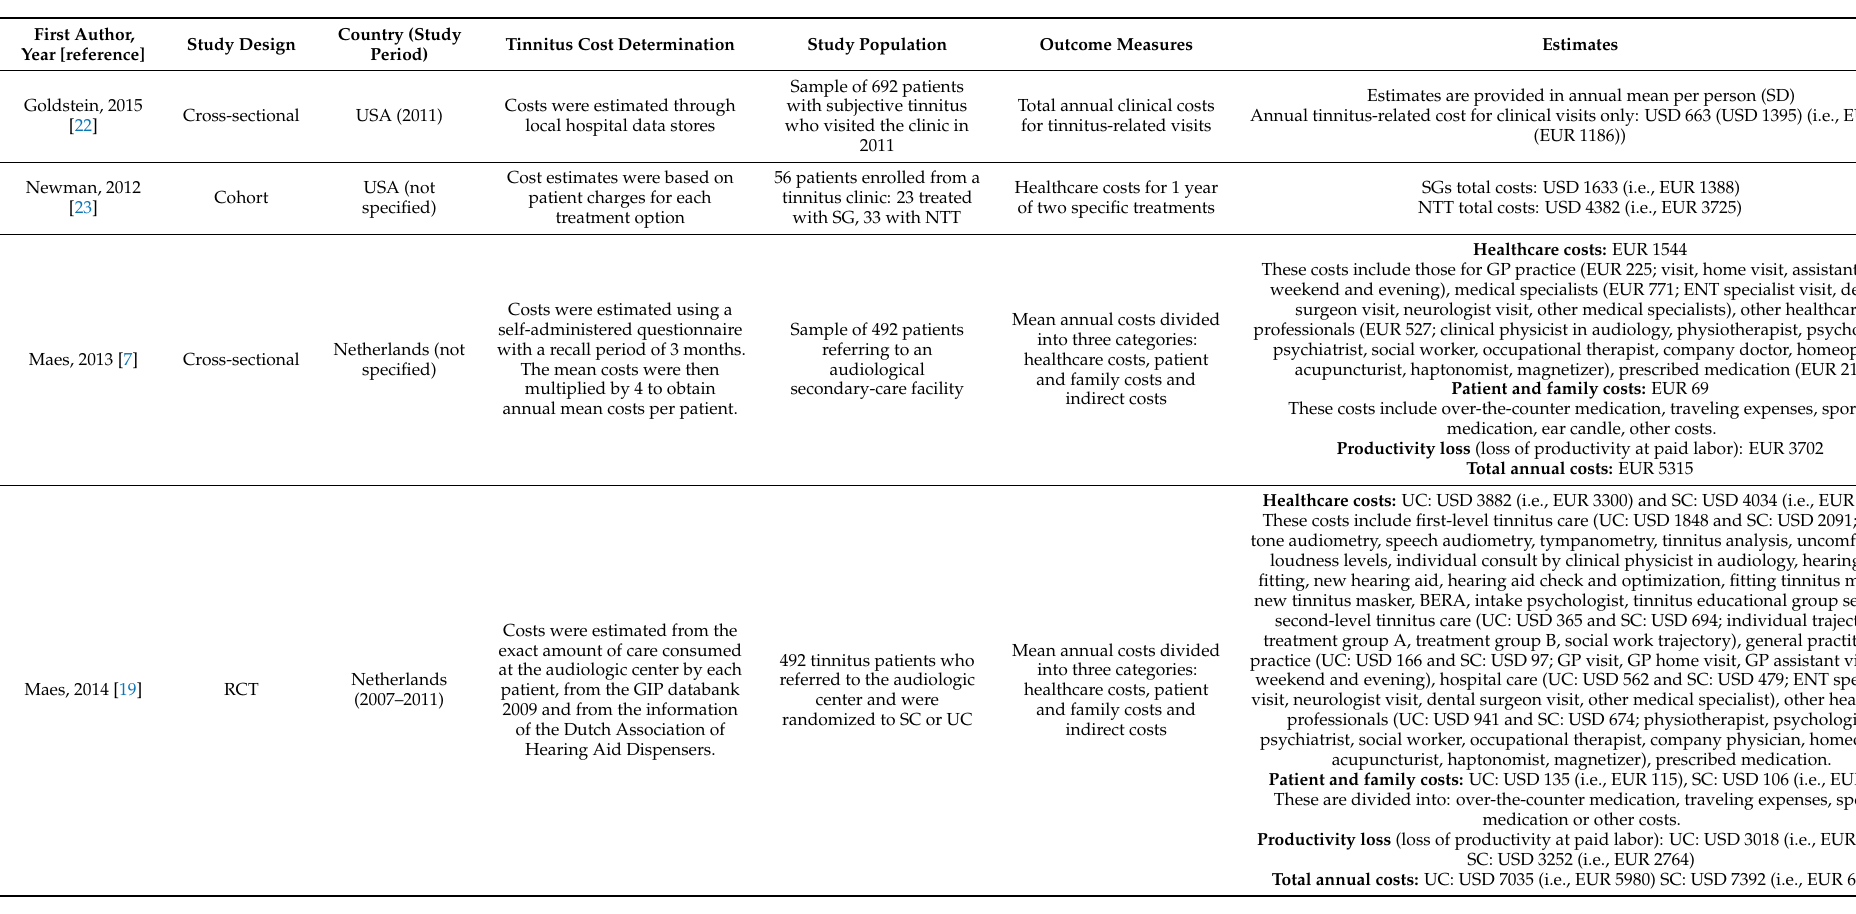
Table 1. Description of eligible studies included in this systematic